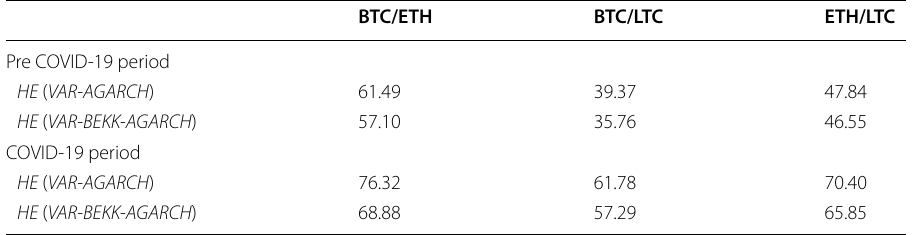
Table 5 Hedging effectiveness (%) for the pairs of cryptocurrencies